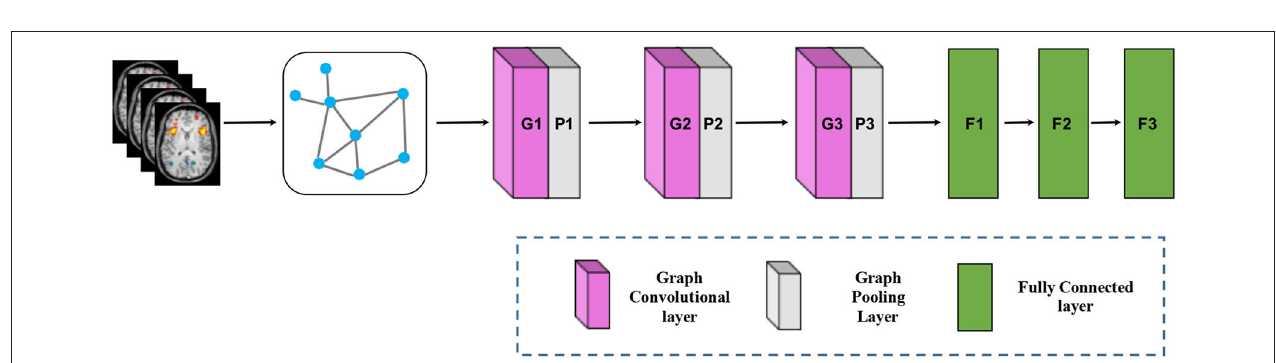
FIGURE 5 | Architecture of convolutional neural networks. Note that an implicit rectified linear unit (ReLU) non-linearity is applied after every layer. The natural images as input data in Krizhevsky et al. (2012) are replaced by brain MR images.